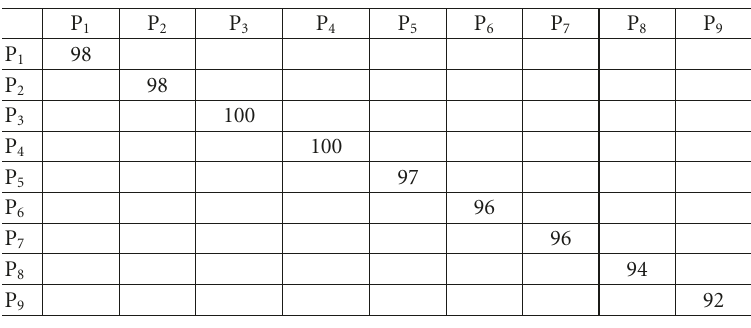
Table 7: Testing performance of the optimized identifier at SNR = 3dB.